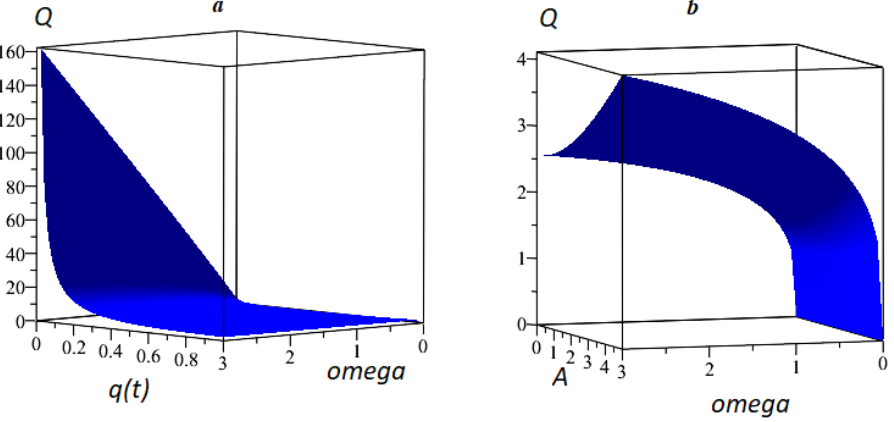
Figure 4. Q-factor: ( a ) A = 1.5, t ∈ [ 96.4,97.5 ] ; ( b ) q ( t ) = sin 2 ( ω t ) , t =